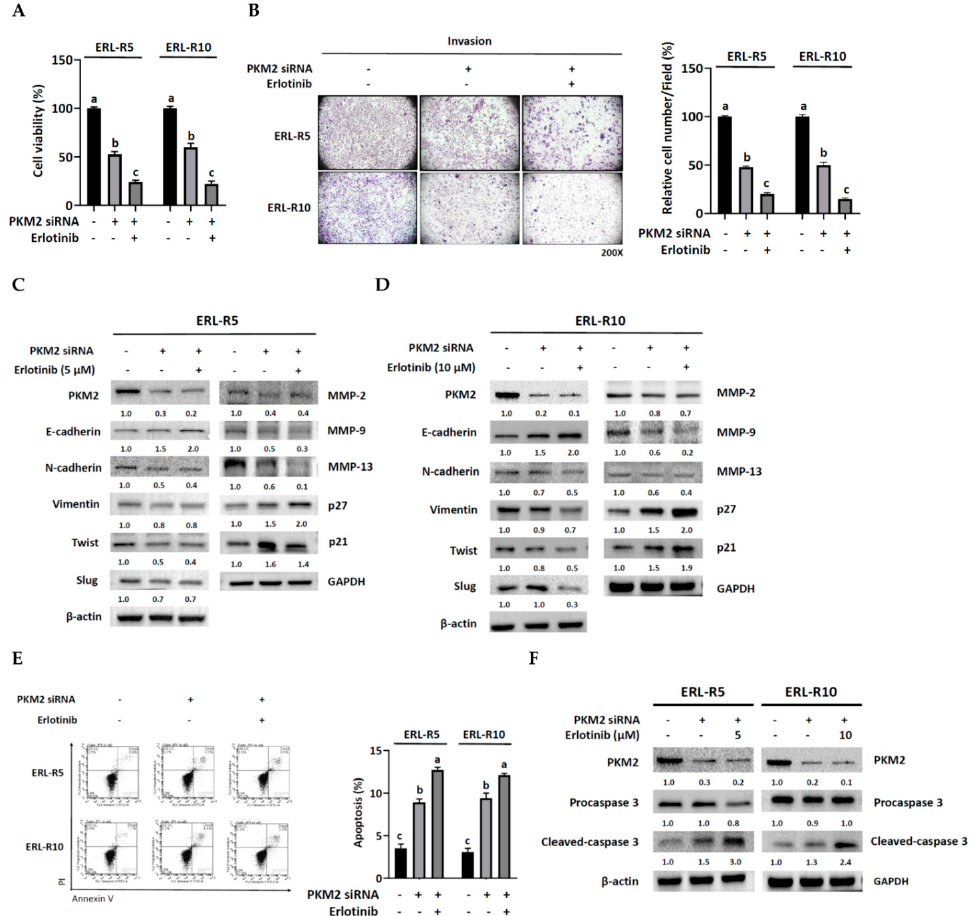
Figure 6. PKM2 knockdown re-sensitizes resistant cells to erlotinib. Both ERL-R5 and ERL-R10 resistant cells transfected with or without PKM2 siRNA were treated with indicated concentration of erlotinib for 24 h, and then cells were subjected to ( A , B ) Western blot analysis for indicated proteins, ( C ) an MTT cell viability assay, ( D ) a Matrigel invasion assay, and ( E ) a flowcytometric analysis for cell apoptosis and ( F ) Western blot analysis for cleaved-caspase 3 protein expression. Values are mean ± SD, n = 3. abc Values with different letter differ significantly at indicated time point, p <